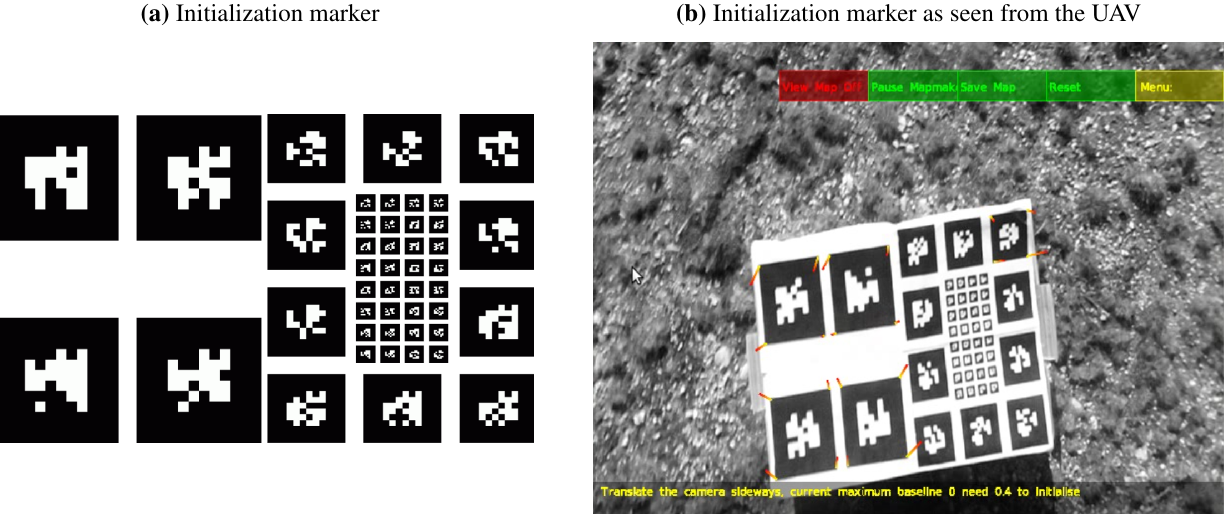
Figure 7. Pattern of markers used to initialize the mapping and tracking algorithm. In (a) we show the design of the marker pattern. In (b) we show a screen capture of the algorithm output window when tracking the marker pattern.